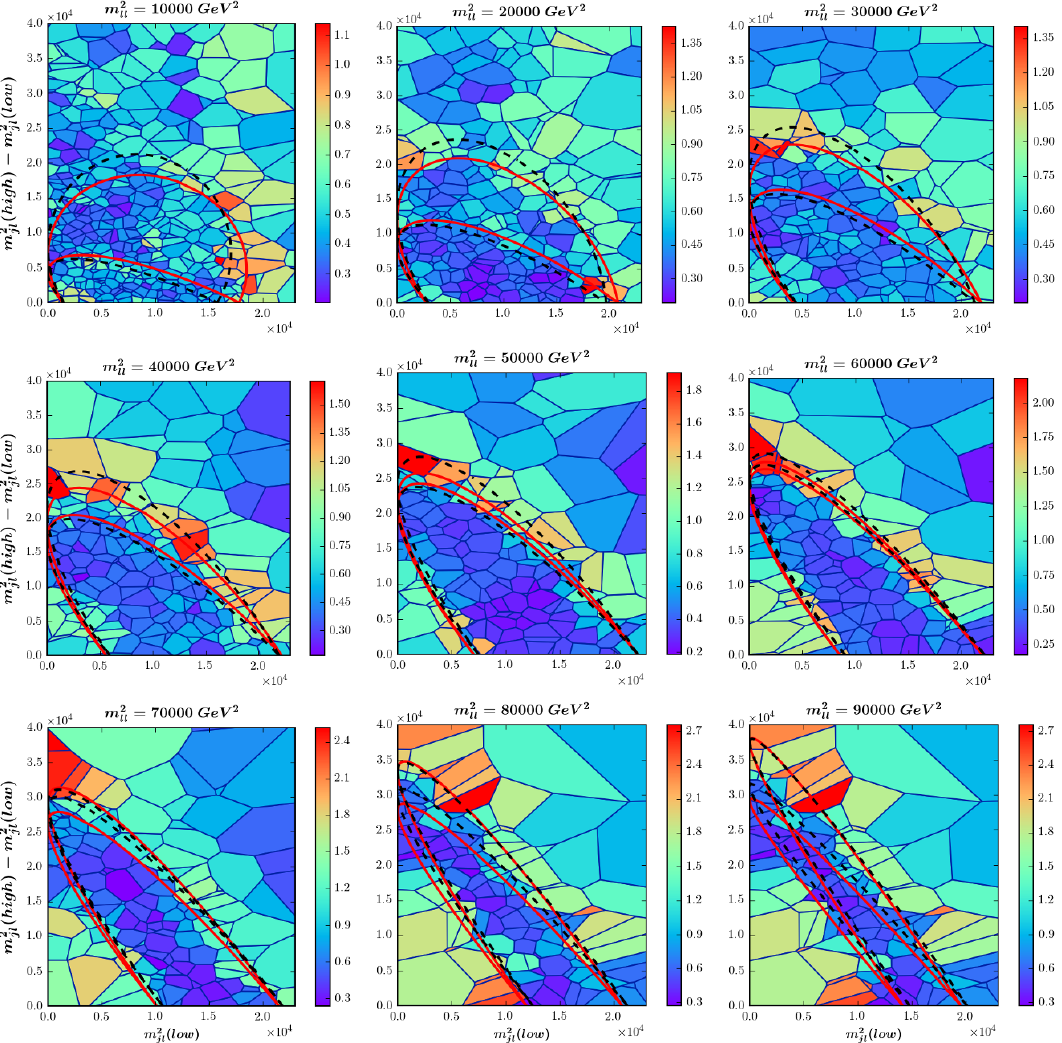
Figure 26 . The same as (cid:12)gure 14, but for the exercise performed in section 4.3, using study point P 32 as input. The red solid line is the phase space boundary for the nominal value m A = 126 : 5 GeV, while the black dashed line corresponds to the best (cid:12)t value ~ m A = 116 GeV found in the top left panel of (cid:12)gure